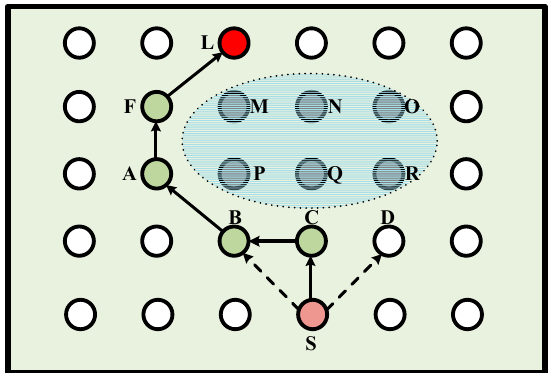
Figure 7. The hole problem of routing path.